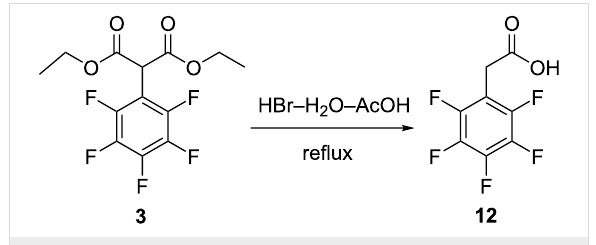
Figure 3: Molecular structure of 2-(perfluorophenyl)acetic acid ( 12 ).